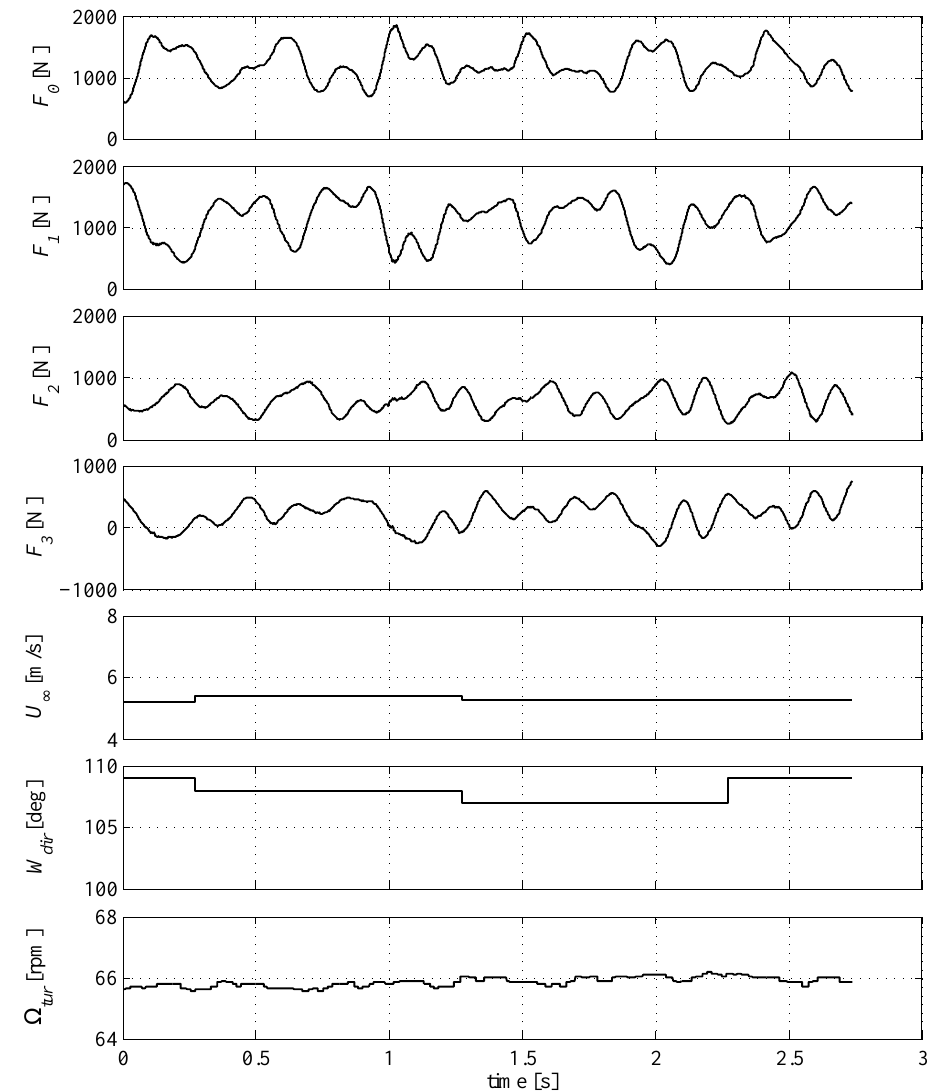
Figure 8. Load cells output, wind speed, wind direction and rotational speed during three turbine